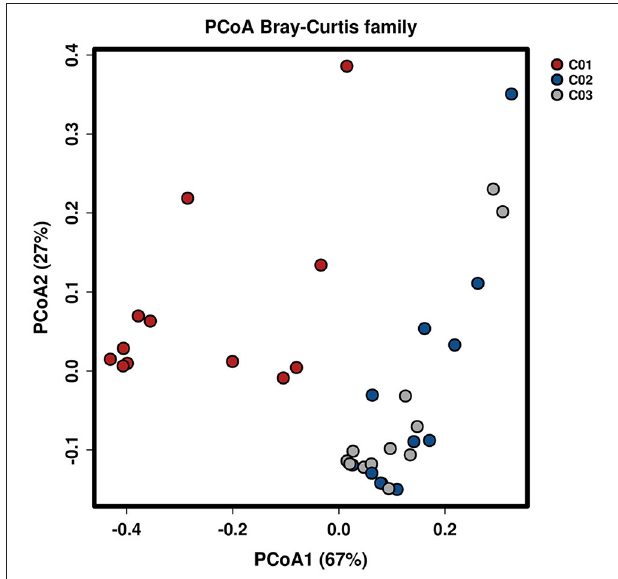
FIGURE 2 | Principal coordinates analysis of BAs in the fecal samples of the three crewmembers (C01, C02, and C03 refers to the three